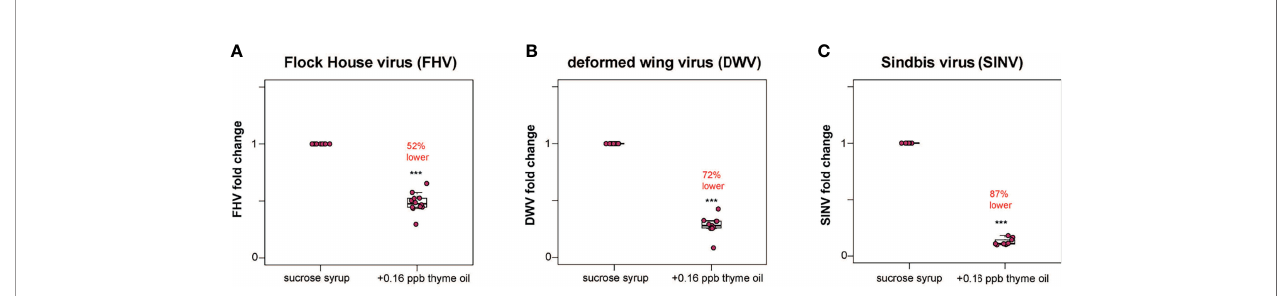
FIGURE 1 | Lower virus abundance in honey bees fed thyme oil augmented sucrose syrup. Virus abundance in individual honey bees that were either fed sucrose syrup only or sucrose syrup augmented with 0.16 ppb thyme oil was assessed at 72 h post-infection by qPCR (n = 9-12 per treatment group) and the relative virus abundance is presented as ranked fold-changes. Together, these data illustrate that virus-infected bees fed thyme oil augmented sucrose syrup harbored less virus than virus-infected bees fed only sucrose syrup. (A) Flock House virus (FHV)-infected bees fed sucrose syrup augmented with thyme oil (0.16 ppb) had 52% less FHV (0.48 mean fold change) than bees fed sucrose syrup alone ( p = 2.1 x 10 -5 ). (B) In deformed wing virus (DWV)-infected bees, virus abundance was 72% less in bees fed sucrose syrup augmented with thyme oil (0.28 mean fold change) compared to bees fed only sucrose syrup ( p = 0.00016). (C) Sindbis virus (SINV)-infected bees fed thyme oil augmented sucrose syrup had 87% less SINV (0.13 mean fold change) than bees fed sucrose syrup. Data were analyzed by a pairwise Wilcoxon Rank Sums with a Benjamini – Hochberg correction for multiple comparisons. Asterisks indicate a signi fi cant difference in virus abundance; signi fi cance levels: *** p < 0.0005. This fi gure includes results from one representative biological replicate for each virus (i.e., rep1). The data for all three biological replicates are presented in Supplemental Figure S2 and raw data are in Supplemental Tables S3 , S4 .